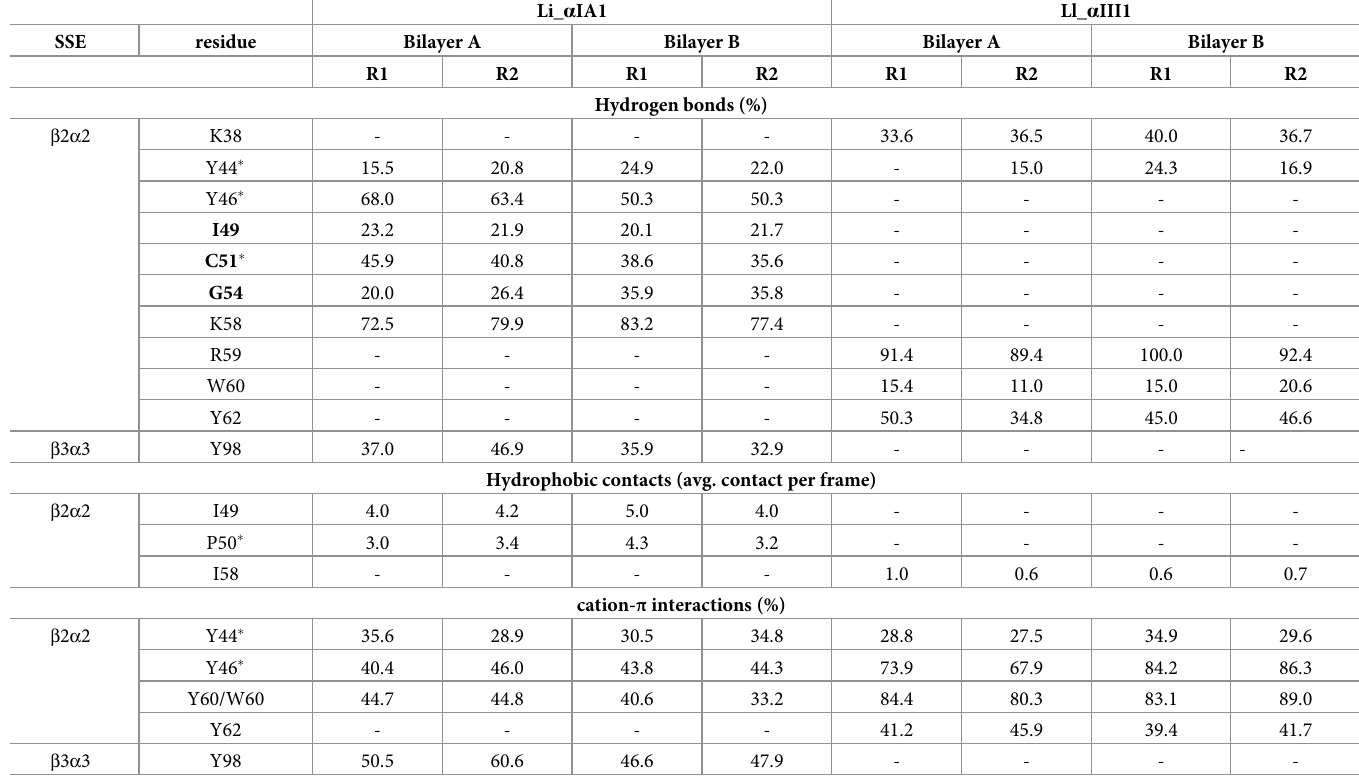
Table 2. Inventory of interactions between Li_ α IA1 (3RLH) or Ll_ α III1 (1XX1) and two types of bilayers: POPC and POPC:PSM:CHOL. Hydrophobic contacts are given as average number of contacts per frame. Hydrogen bonds and cation- π occupancies are shown in percentages. Residues in bold indicate hydrogen bonds involving the amino acid backbone. Asterisk ( � ) indicates strictly conserved positions between Li_ α IA1 and Ll_ α III1. Li_ α